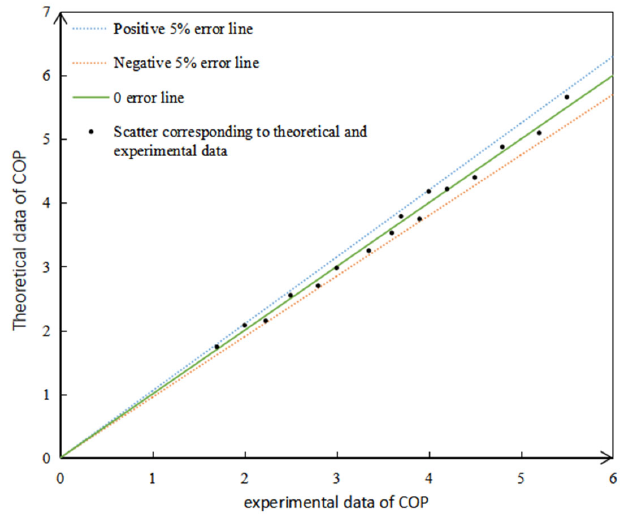
Figure 11. Comparison between the experimental data and simulation data.